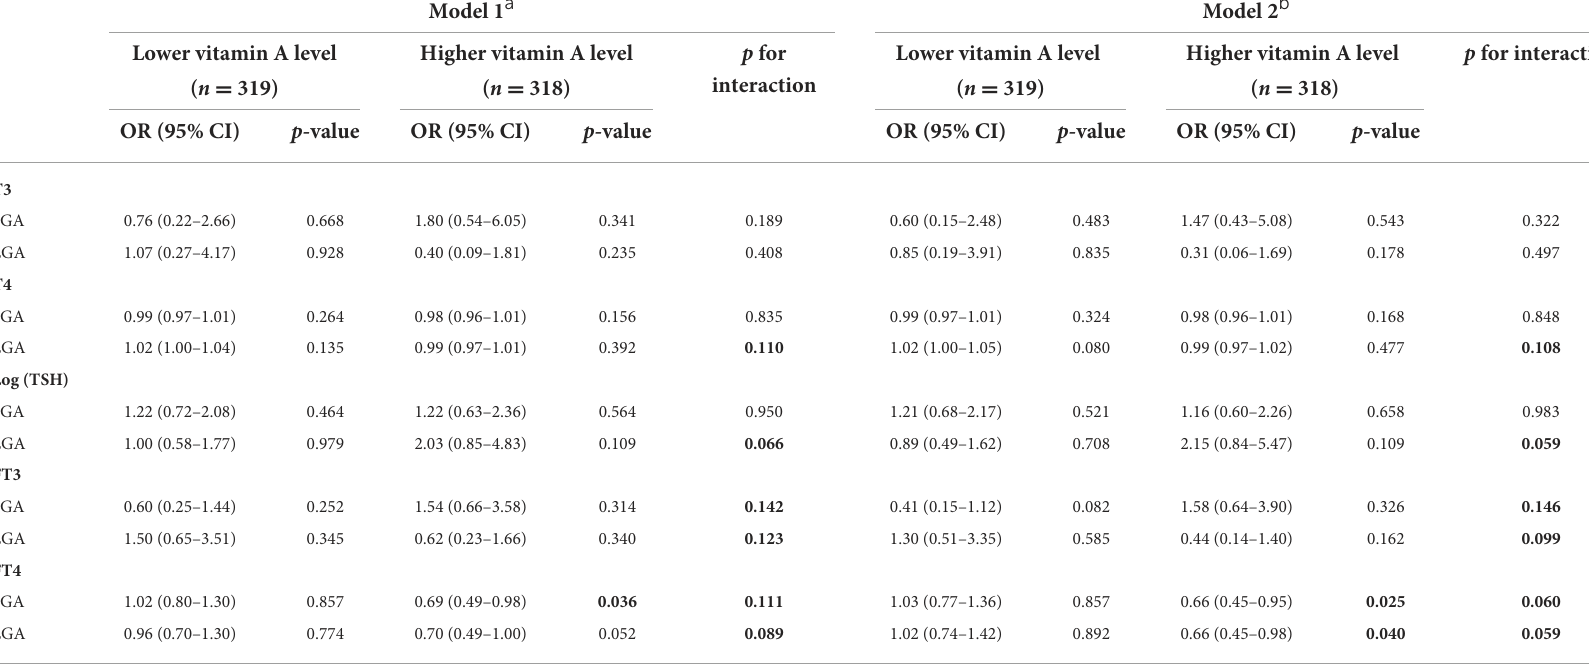
TABLE 5 Associations between maternal thyroid hormones in early pregnancy and odds of SGA or LGA infants in multinomial logistic regression models, stratified by vitamin A